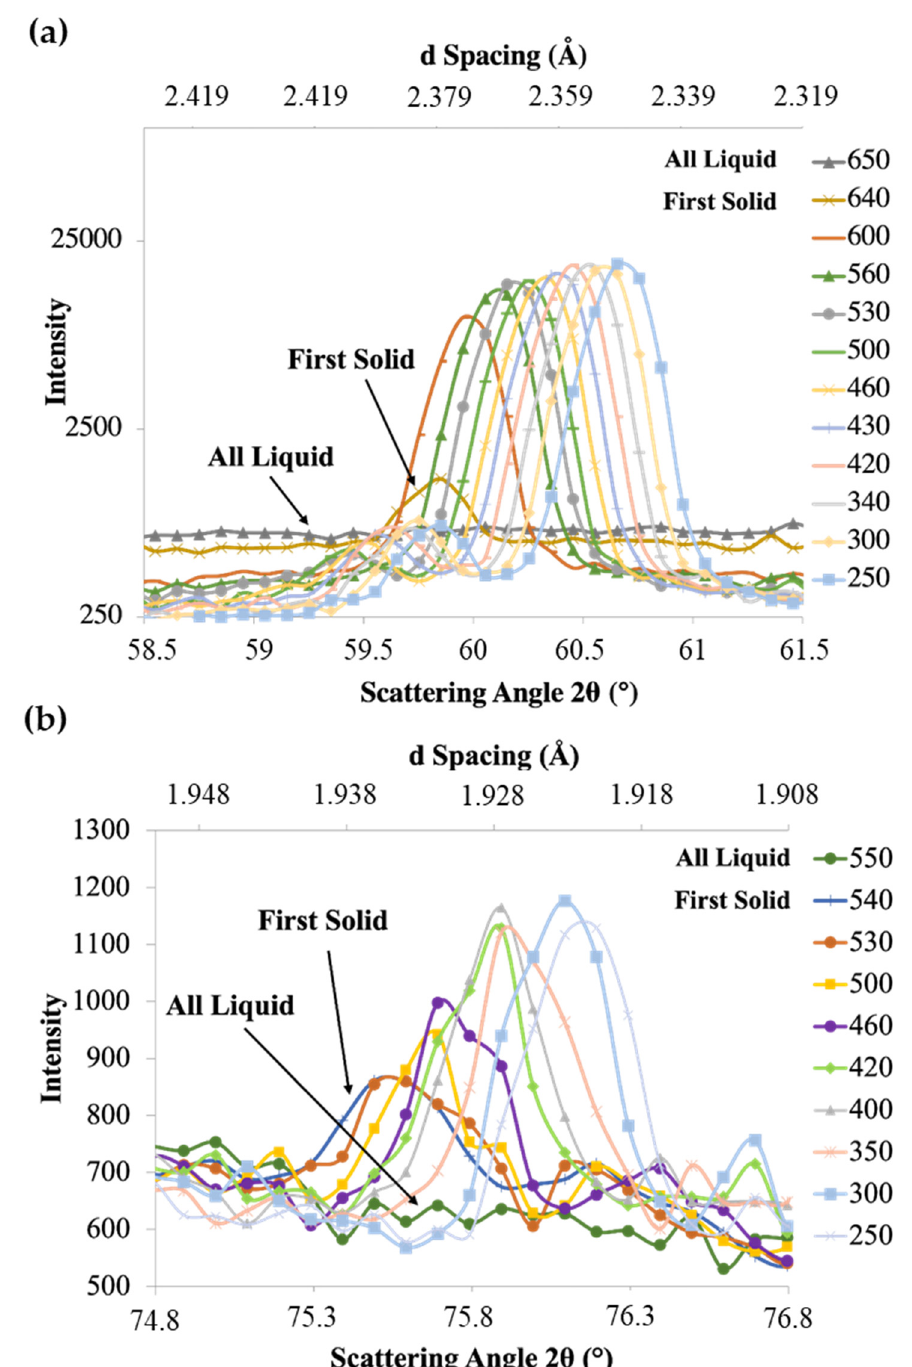
Al-Cu alloy at different temperatures ( ◦ C, select isotherms omitted for